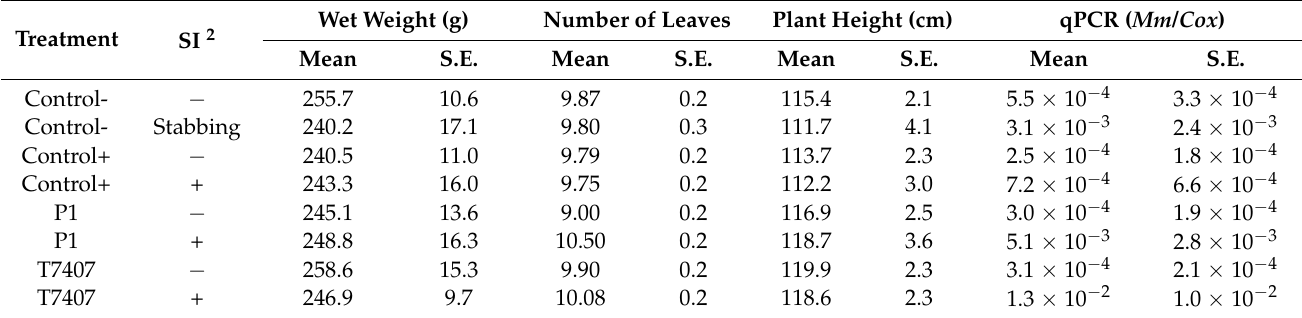
Table 5. Trichoderma spp. late wilt control in the 2020 growing season at 41 DAS 1